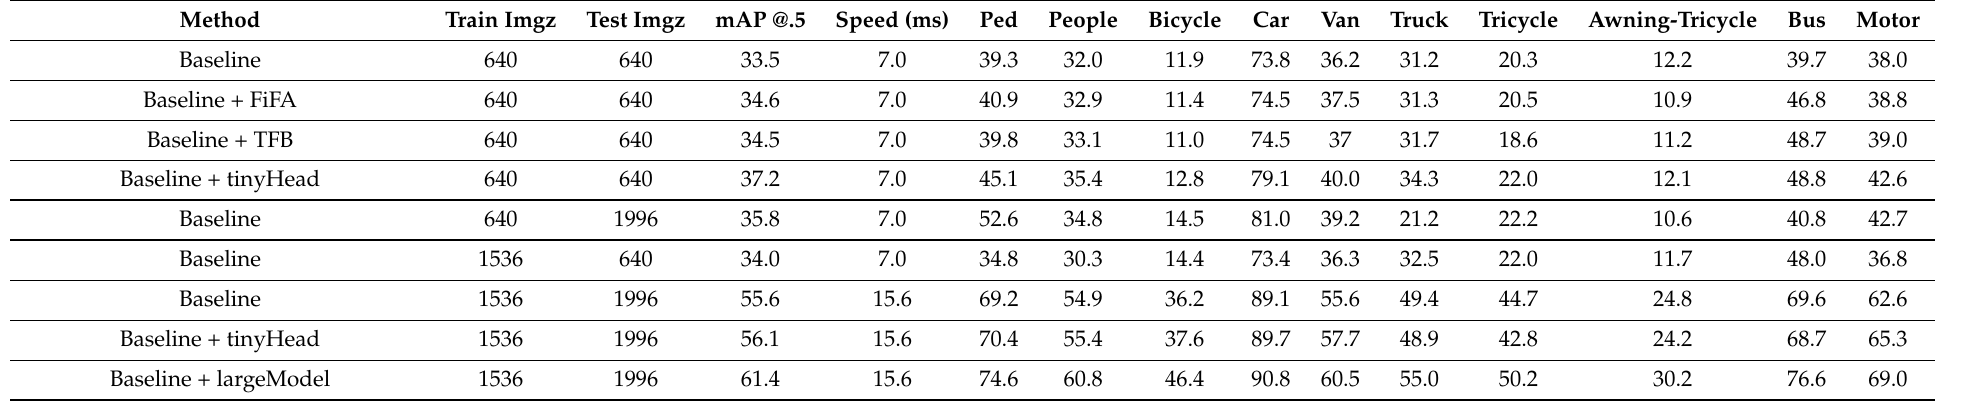
Table 3. Comparison of Average Precision obtained with our method with/without each module for small object detection on VisDrone2019-Val.